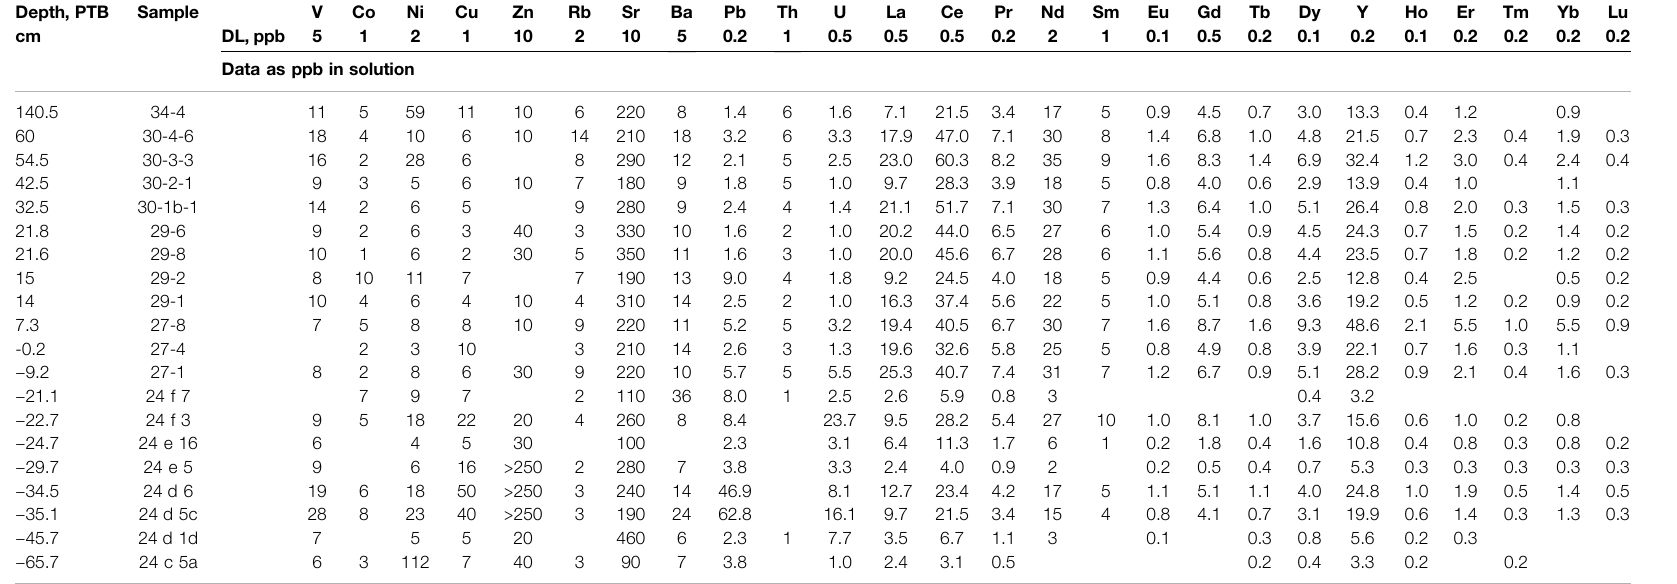
TABLE 4 | Summary of acetic acid extract